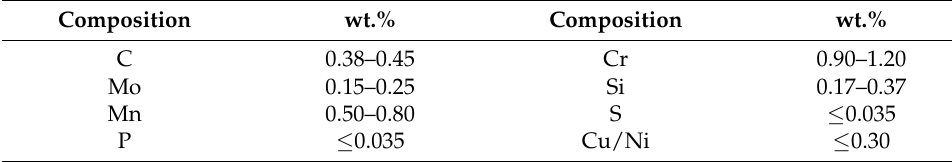
Table 2. Chemical composition of 42CrMo steel (wt.%).